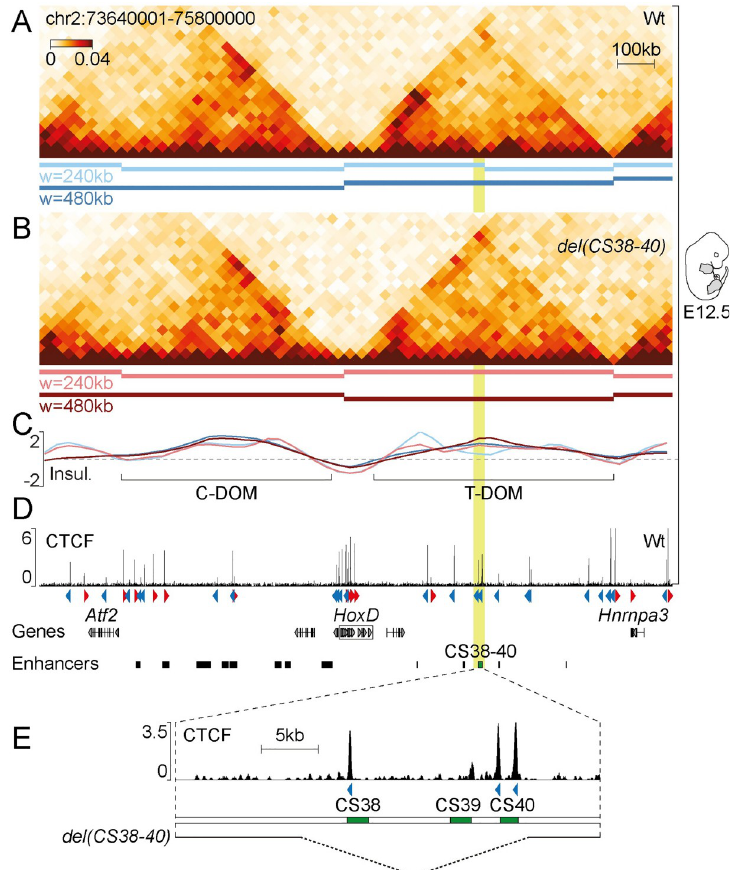
Fig 1. Region CS38-40 is a sub-TAD boundary of the HoxD locus. (A, B) Hi-C of the HoxD locus in wild-type (A) and del(CS38-40) (B) whole limbs at E12.5. Topological domains (TADs or sub-TADs) were identified using a window size (w) of 240 kb (light-coloured bars) or 480 kb (dark-coloured bars) and are represented below each Hi-C heatmap. (C) Insulation scores computed with two different window sizes (see above). (D) Wild-type ChIP-seq of CTCF in E12.5 whole limbs. CTCF orientations are indicated by red or blue arrowheads. (E) Magnification of region CS38-40 (mm10, chr2:75122684–75160161; highlighted in light green in previous panels) from panel D. The extension of the deletion in del(CS38-40) (mm10, chr2:75133816–75153815) is shown as a dashed line at the